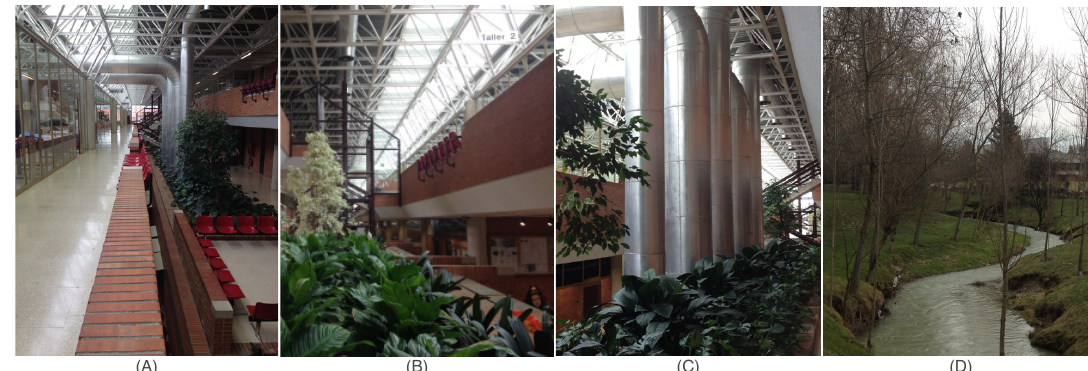
Figure 5. ( A , B ) Skylight in the central area of the building and the brick configuration of the walls. ( C ) Ducts for air distribution. ( D ) The Sadar